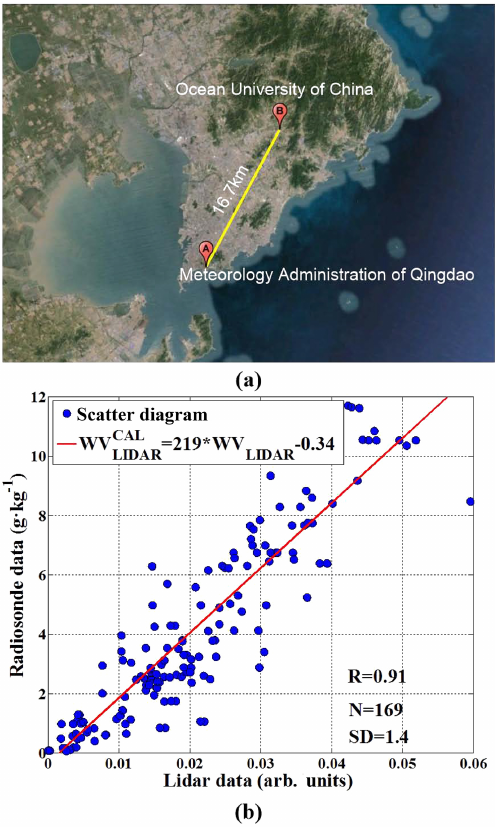
Figure 2. (a) Distance between sites of WACAL and radiosonde; (b) regression of WACAL mixing ratio profile to radiosonde mea- surement.